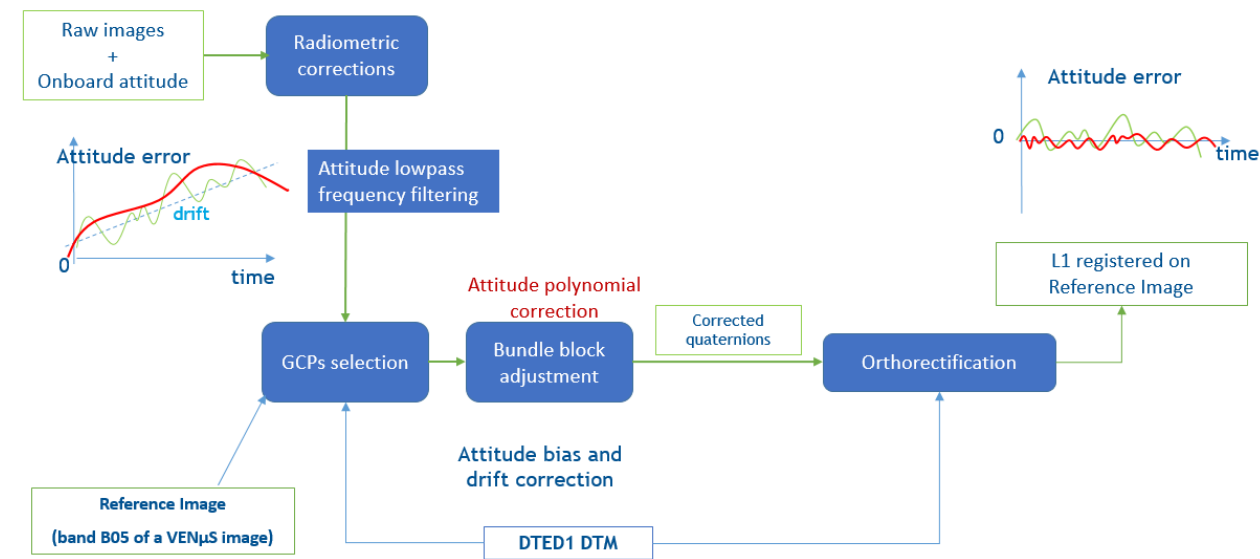
Figure 18. Enhanced attitude correction—L1 VEN µ S image processing.